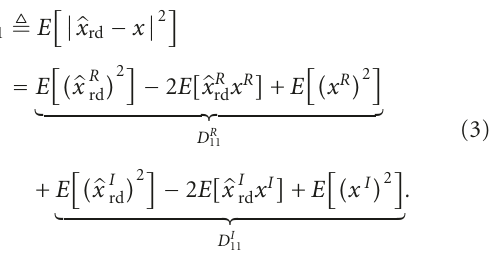
Figure 1: System model for the quantize-and-forward protocol.